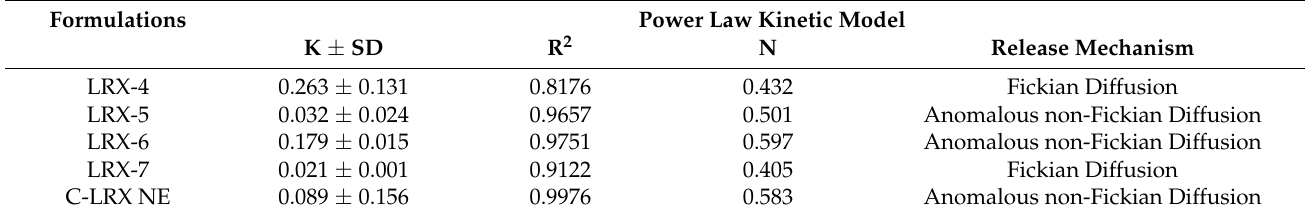
Table 5. Kinetic modeling of selected LRX-NE formulations.